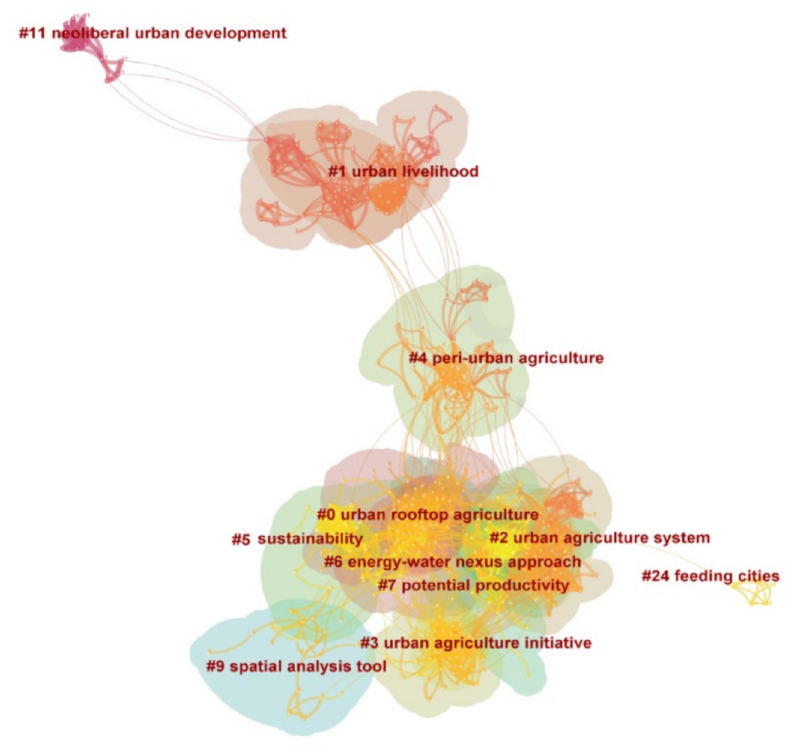
Figure 7. Cluster analysis of papers published on urban agriculture from 2001 to